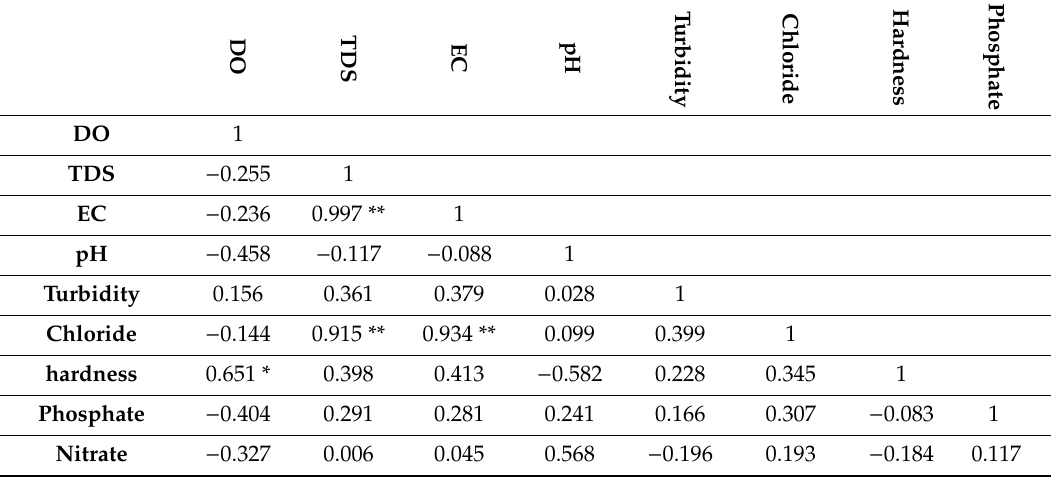
Table A2. Pearson’s linear Correlation Correlations matrix .